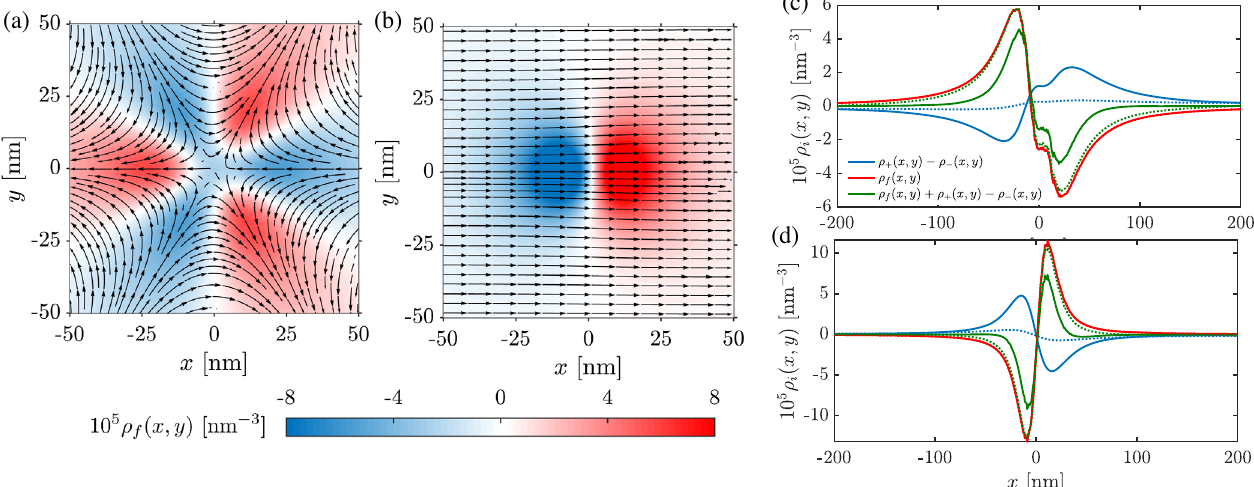
FIG. 6. Comparison of flexoelectric bound charge with the ion free charge density in (cid:1) 1 = 2 wedge disclinations. (a,b) Flexoelectric x; y Þ as a color map, with arrows indicating the direction of the flexoelectric polarization q polarization charge density ρ f ð g ¼ 0 , q e G ¼ 10 pC m − 1 , and κ − 1 ¼ 10 nm for (a) k ¼ − 1 = 2 and (b) k ¼ 1 = 2 . (c,d) Charge profiles along the x axis for the same (cid:1) I parameter values, where we also compare with the net ion-charge density ρ The solid lines are for κ − 1 ¼ 10 nm, while the dotted lines are for κ − 1 I